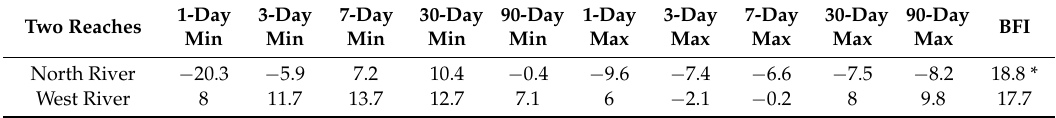
Table 4. The change of magnitude and duration of annual extreme streamflow condition in the JRW (%).